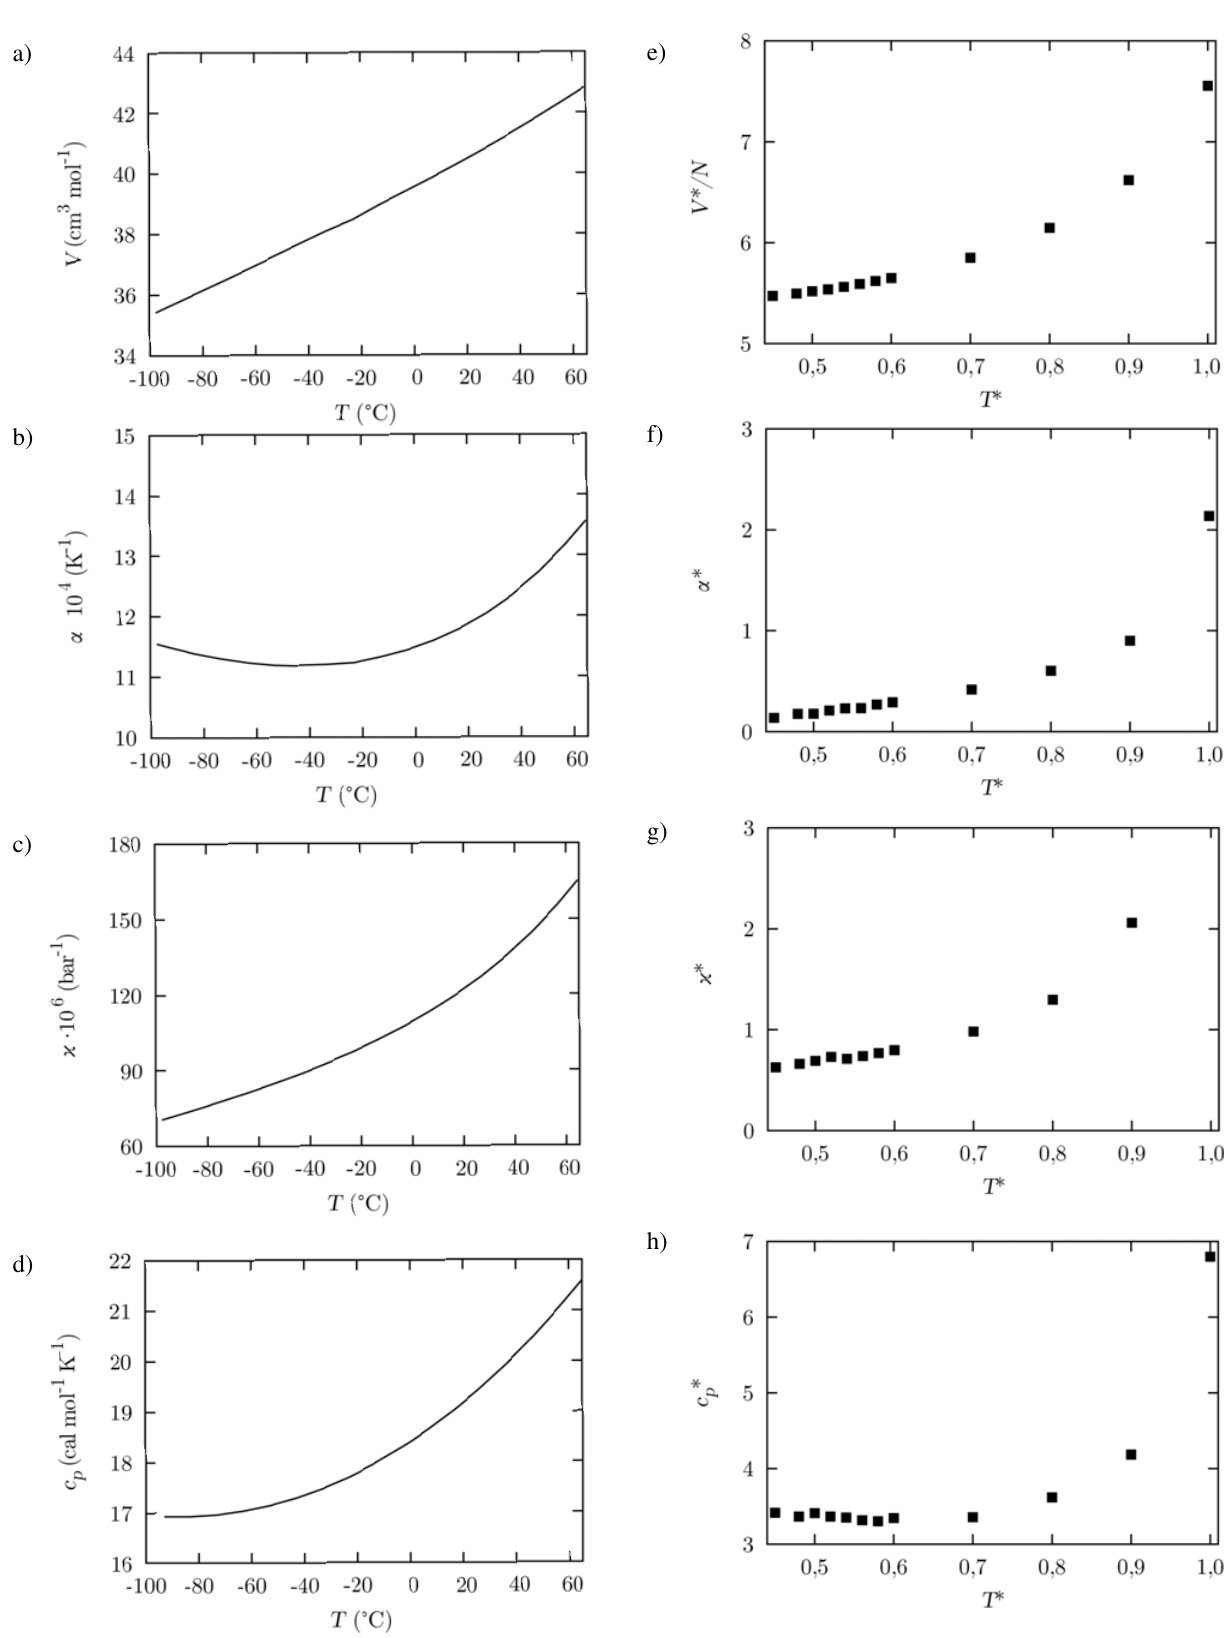
Figure 3: Thermodynamic properties of pure methanol at 1 atm (panels a–d) and results from the model (e–h) at subcritical pressure p* = 0.018 follow matching